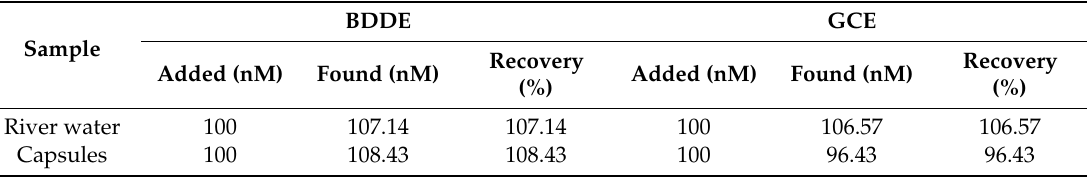
Table 1. Real sample analysis.